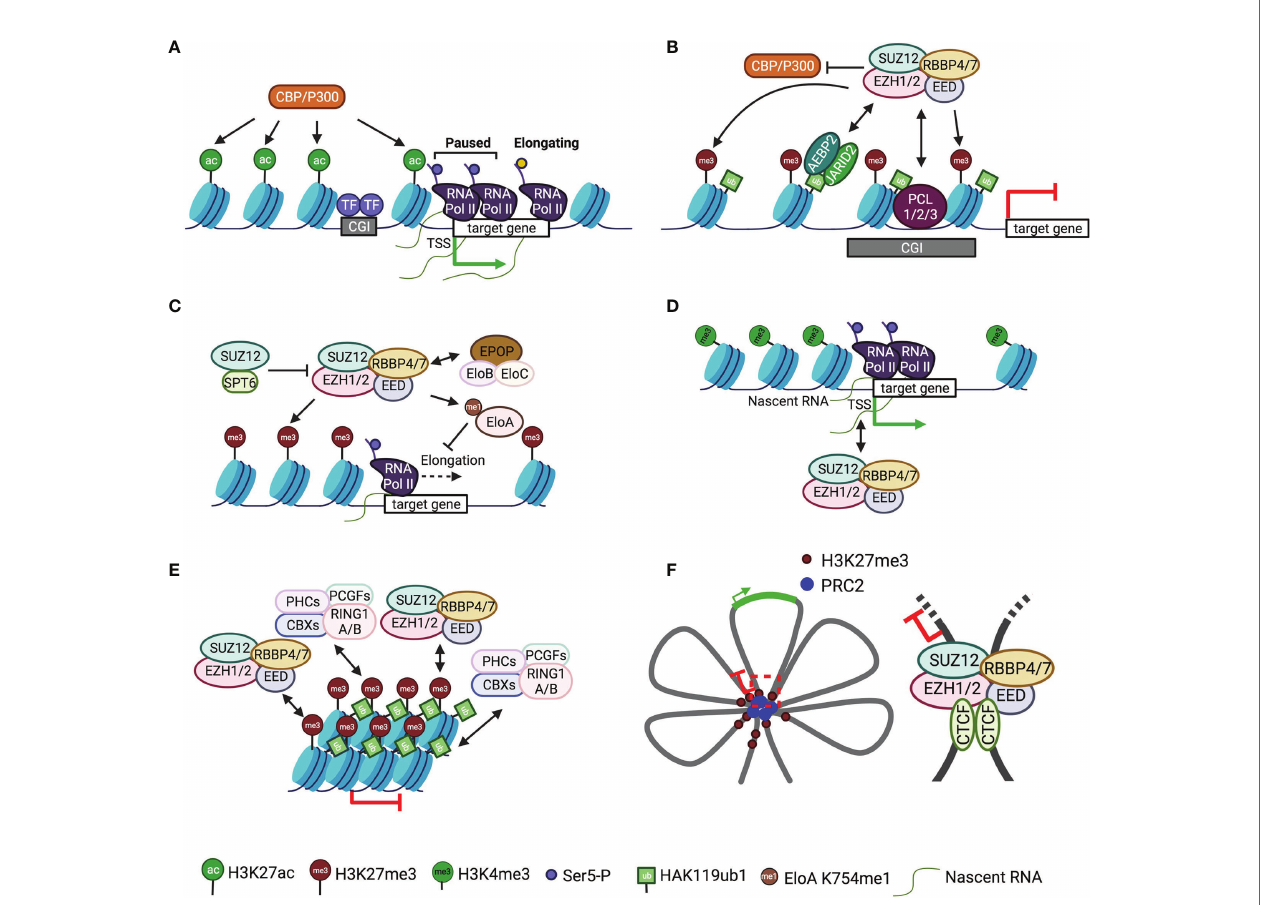
FIGURE 2 | Mode of action of PRC2 in gene regulation A schematic of the mode of action of PRC2 is shown. Single-headed arrows depict the deposition of histone marks, and double-headed arrows indicate chromatin or RNA binding. (A) A simpli fi ed version of the schematic of typical active gene loci. (B) Antagonistic action of PRC2 and P300/CBP in histone H3K27 modi fi cation. (C) Crosstalk of PRC2 with transcription elongation factors. (D) Interaction of PRC2 with nascent RNAs. (E) Chromatin compaction by PRC2 and PRC1. (F) Left, schematic of multiple connected chromatin loops with repressed and active loci; right, a representative chromatin loop bound by CTCF and